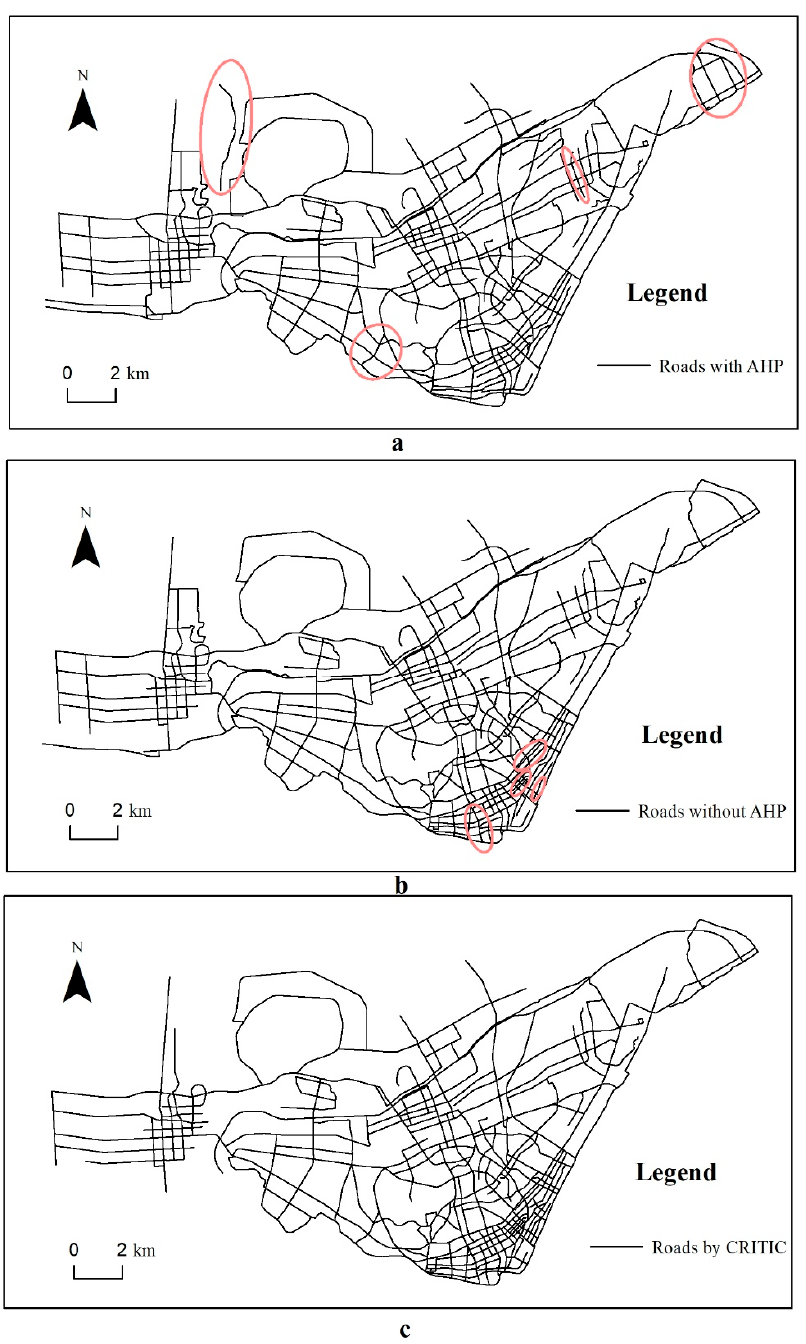
Figure 7. Generalized road networks with AHP ( a ), without AHP ( b ), and by CRITIC ( c ).